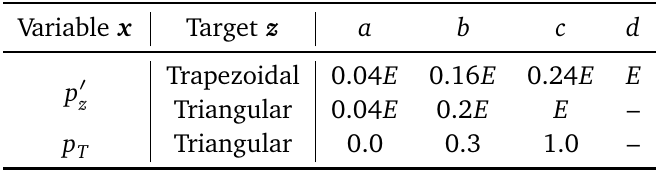
and p latent-space distribution T z